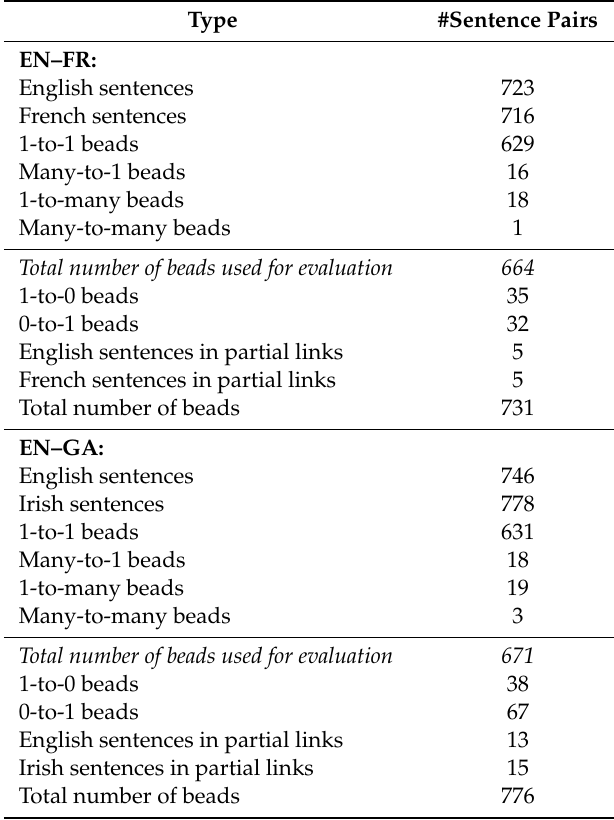
Table 4. Gold standard statistics (EN–FR and EN–GA). Note that partial links involve two partially equivalent sentences that are not part of a bead; they are considered as a combination of a 0-to-1 bead and a 1-to-0 bead, hence they are